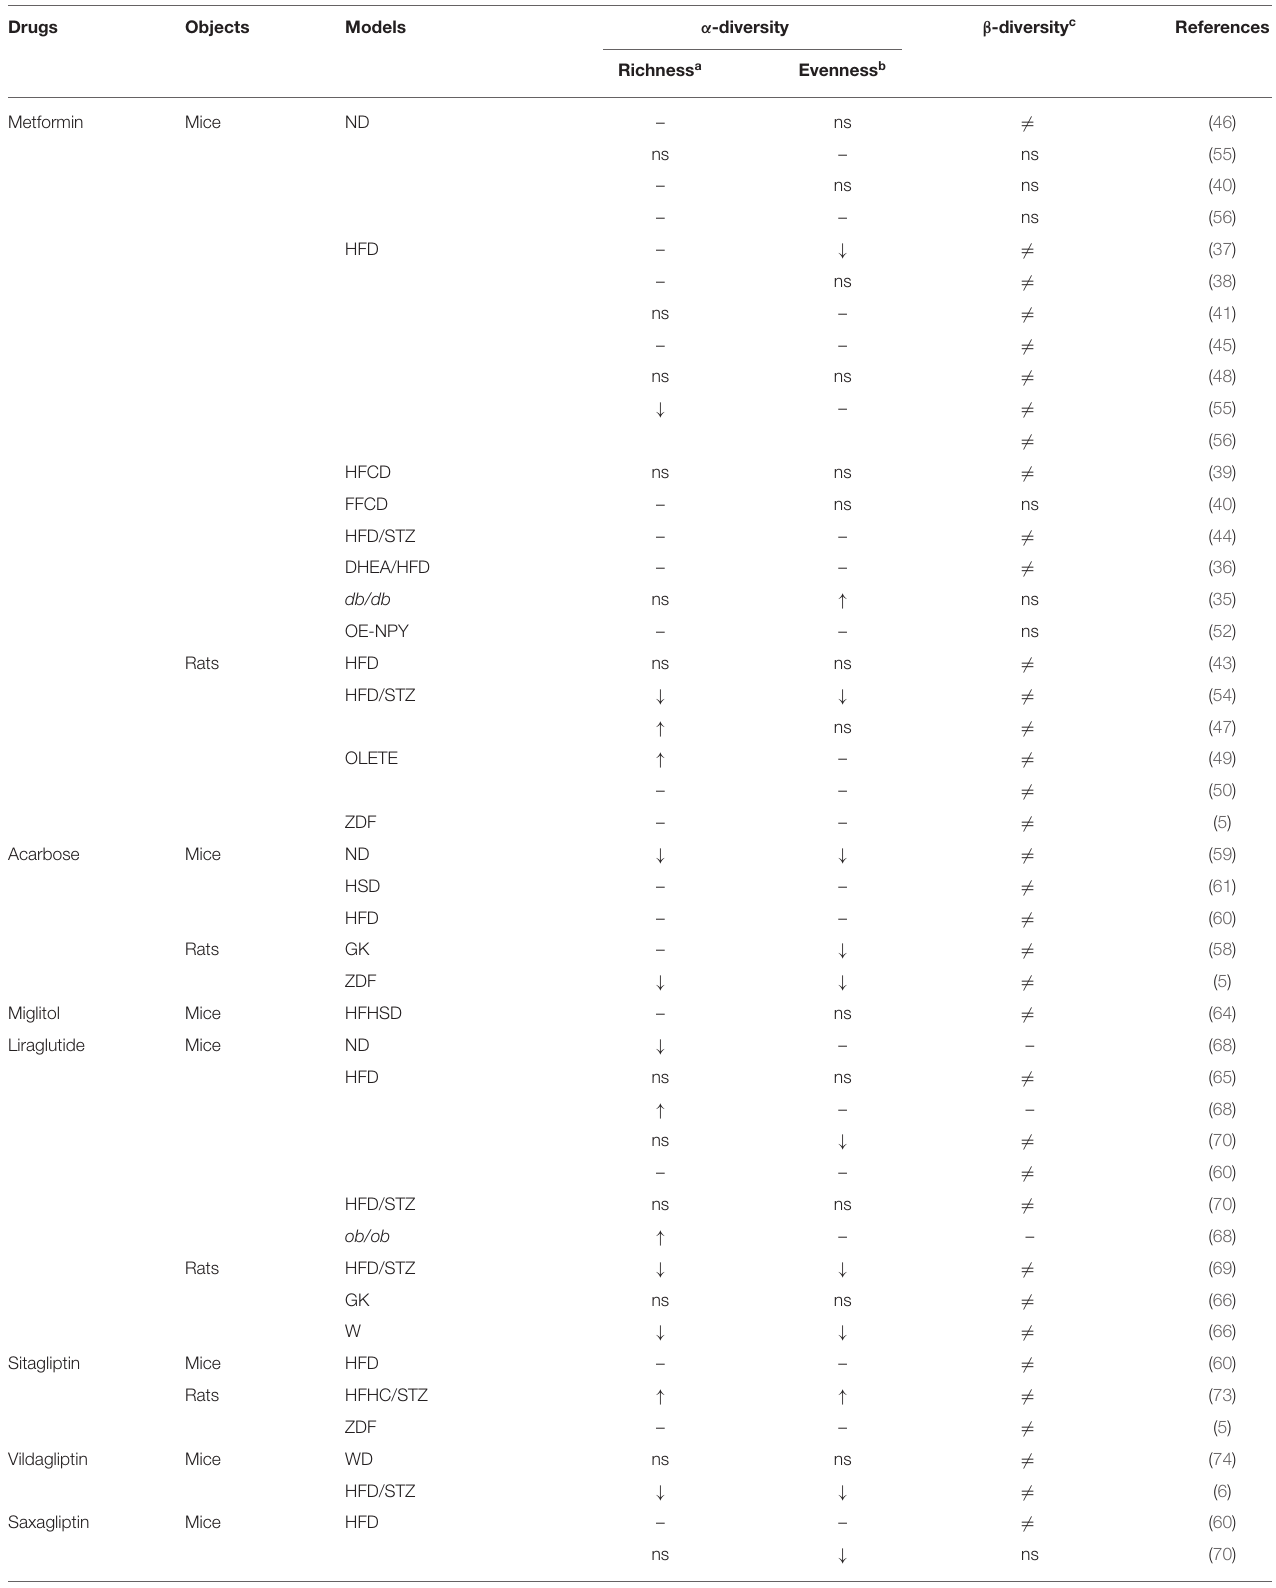
TABLE 9 | Effects of anti-hyperglycemia drugs on diversity in mouse gut